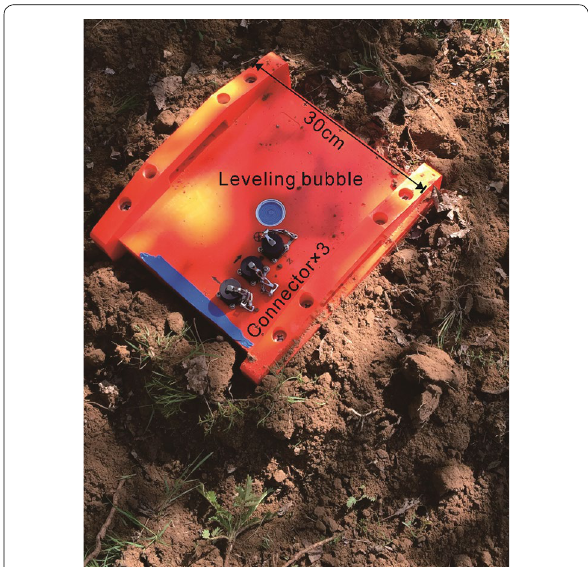
Fig. 6 Photograph of the triaxial induction coil sensor